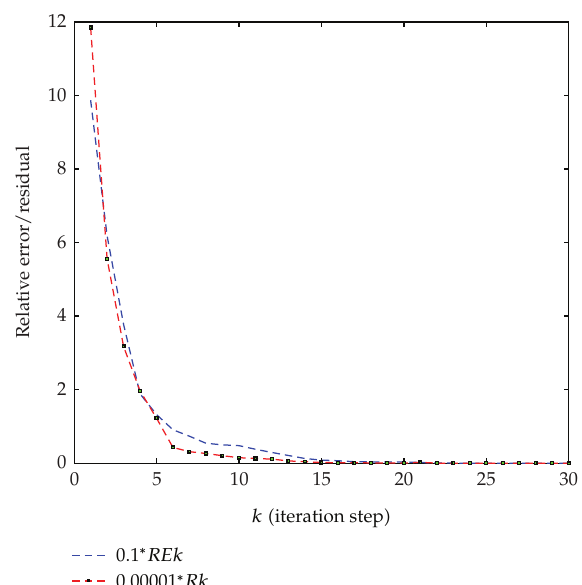
Figure 3: The relative error of the solutions and the residual for Example 4.2.